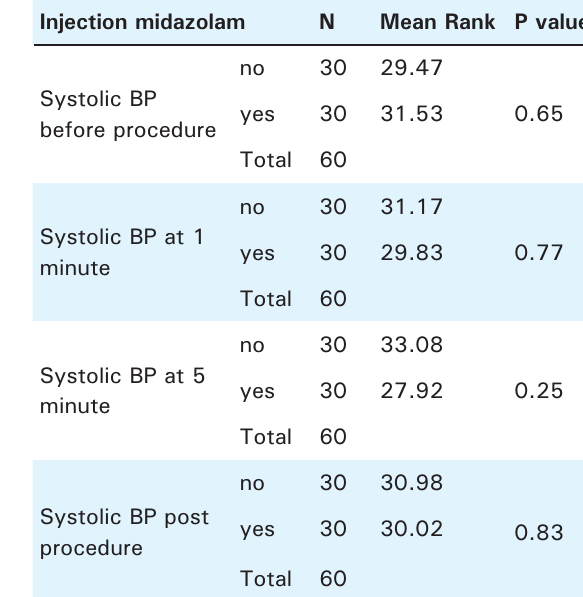
Table 1. Difference in oxygen saturation level means at different stages of procedure